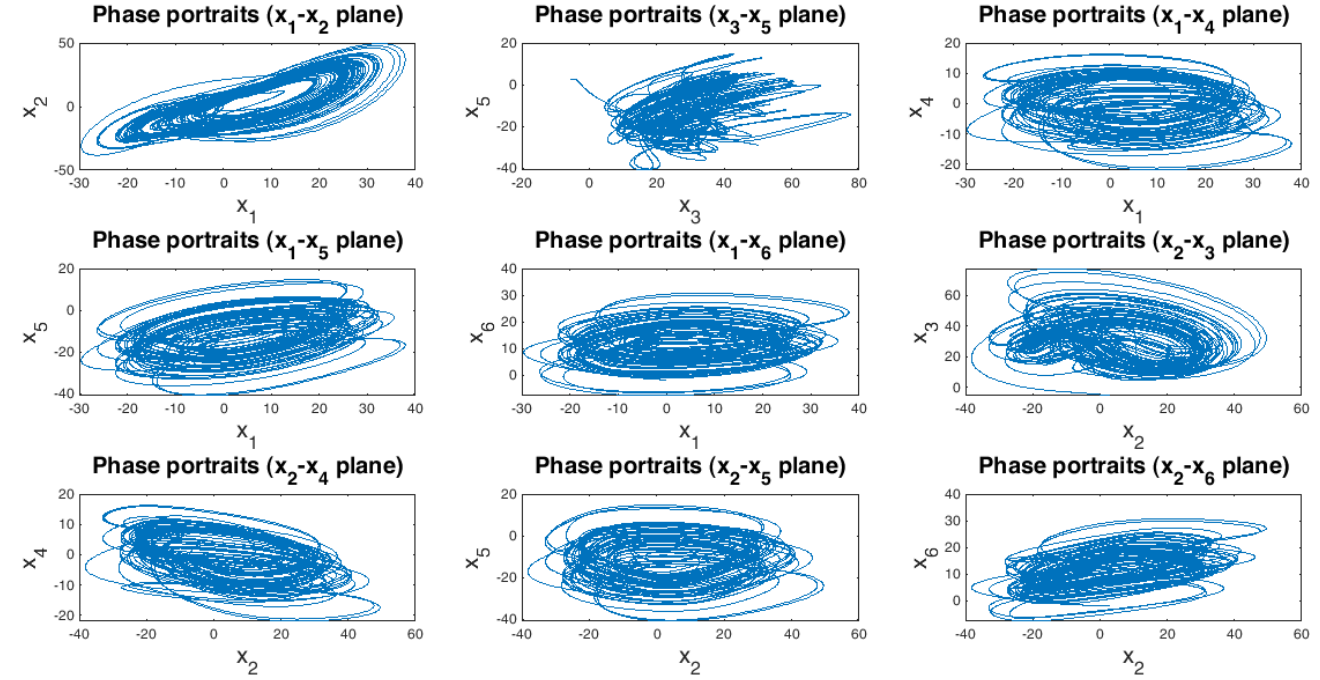
Figure 6. MATLAB PLOT hyperchaotic attractors of the new chaotic system (43) .